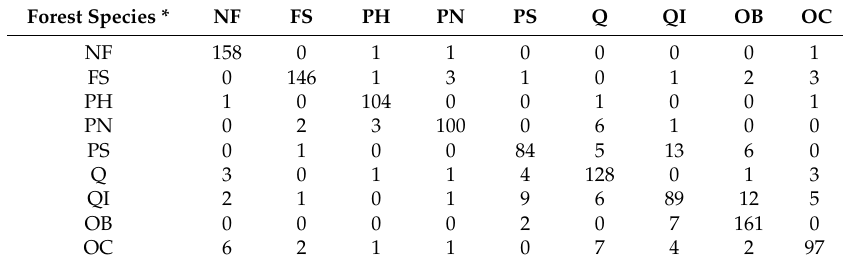
Table A2. Out-of-bag confusion matrix derived from the RF classification model fitted to construct a forest species map for the study area. Columns represent true classes, while rows represent the classifier’s